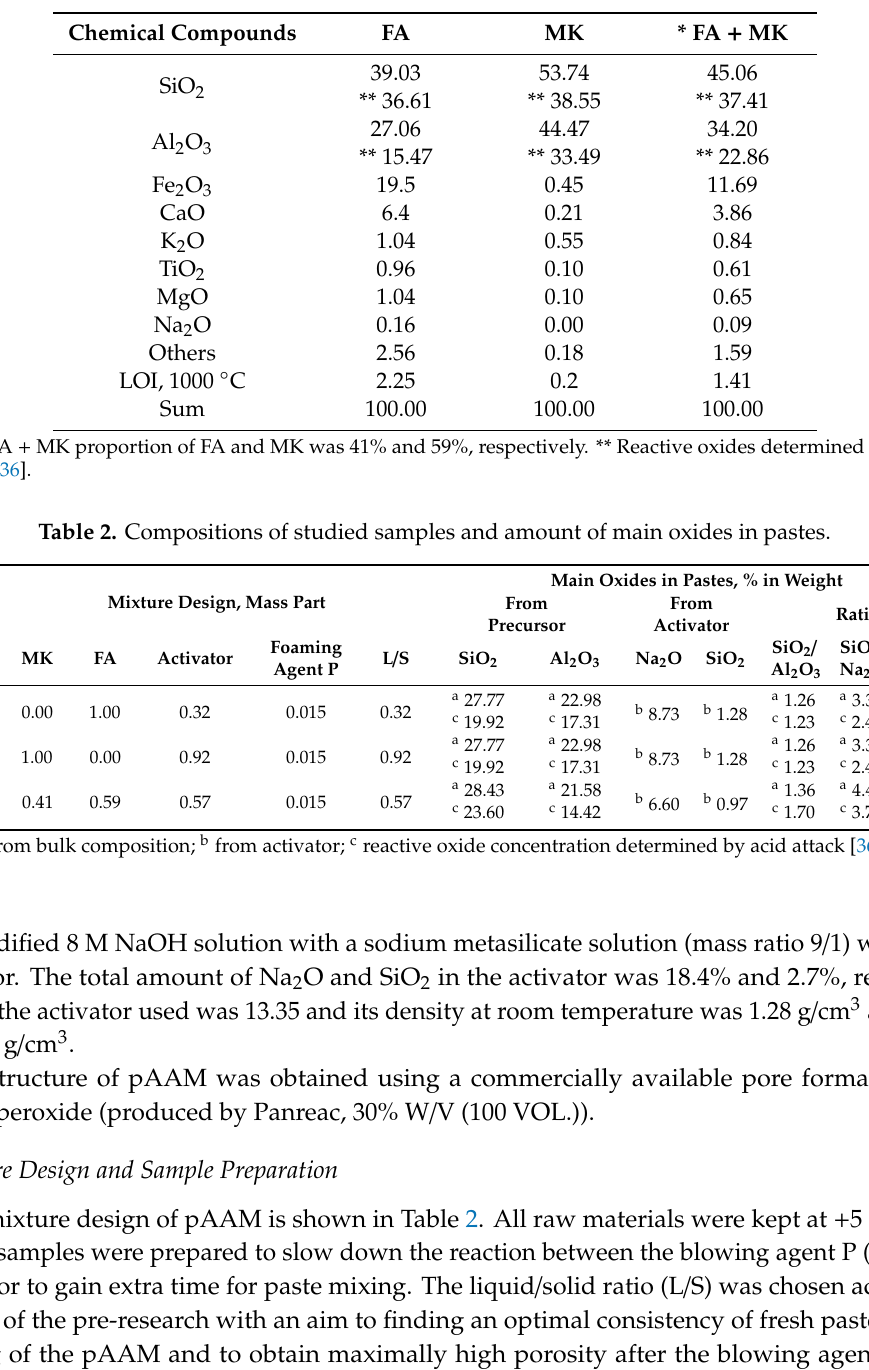
Table 1. Chemical composition of solid raw materials (wt.%).